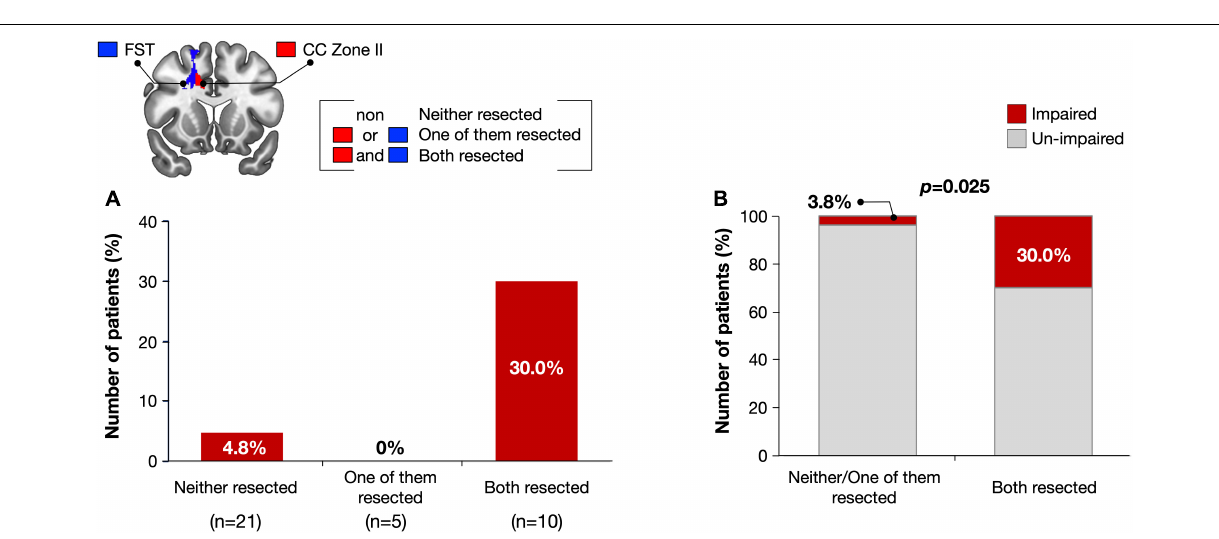
FIGURE 6 | Number of impaired patients were compared among three groups; Subjects with both FST and CC Zone II resected, subjects with only one of them resected, and subjects with neither of them resected (A) . Only when the CC zone II and FST were damaged simultaneously, attentional deficit was remained with significantly high possibility (B)